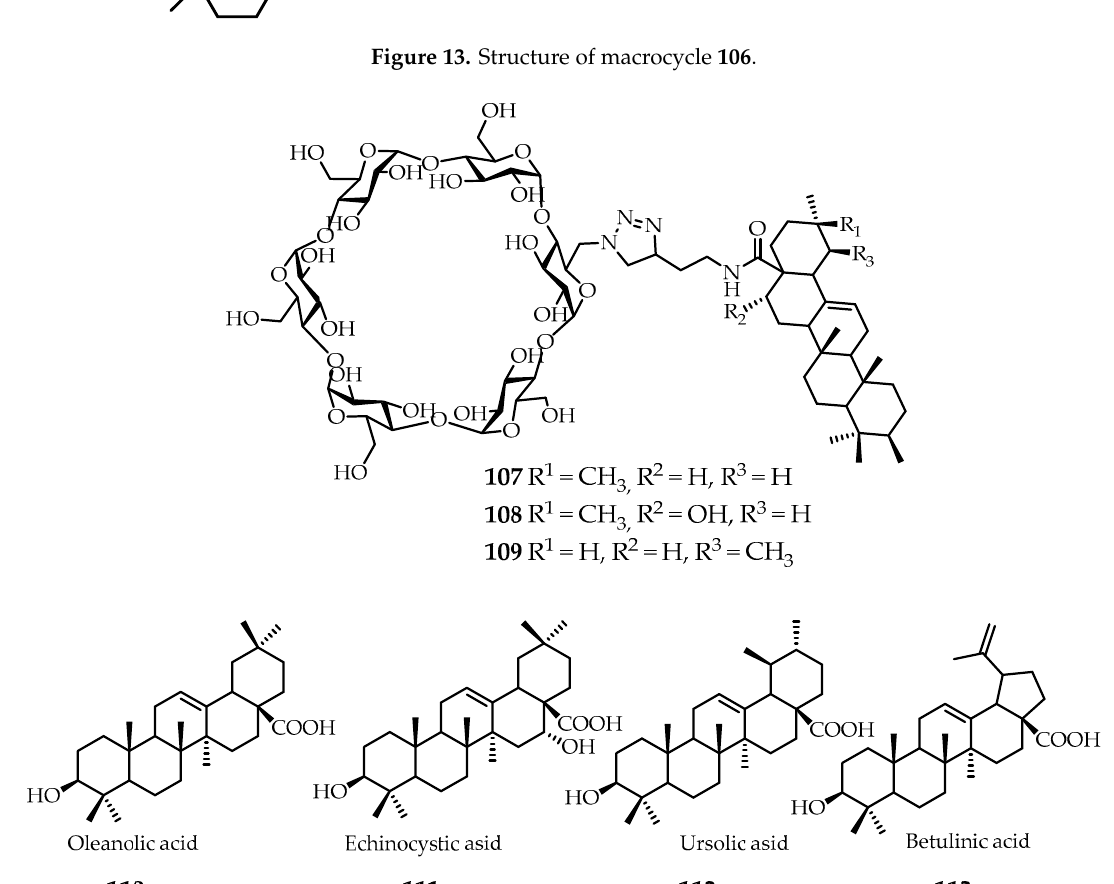
Figure 13. Structure of macrocycle 106 . Plants 2020 , 9 , x FOR PEER REVIEW